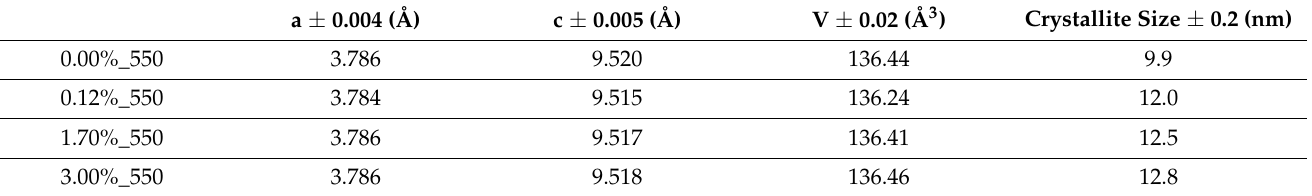
Table 4. Anatase lattice parameters, cell volumes, and crystallite sizes of the HSs calcined at 550 ◦ C. a ± 0.004